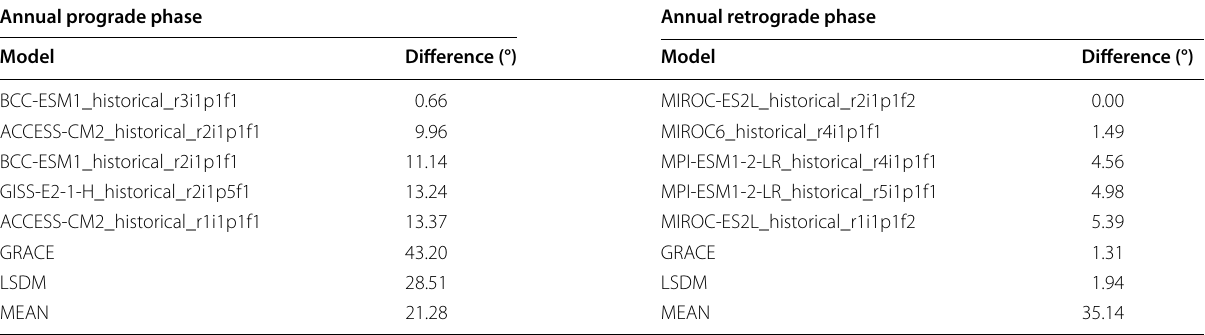
The results obtained from GRACE, LSDM, and MEAN model are also shown